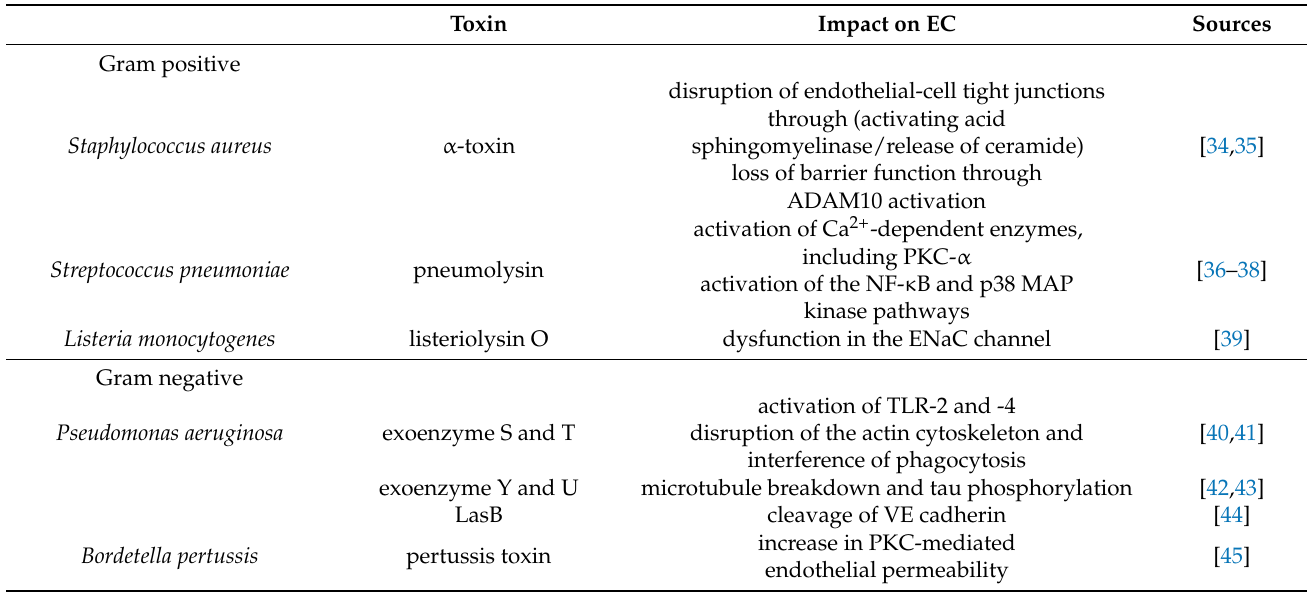
Table 1. Exemplary effects of various bacterial toxins on lung endothelial cells (EC).